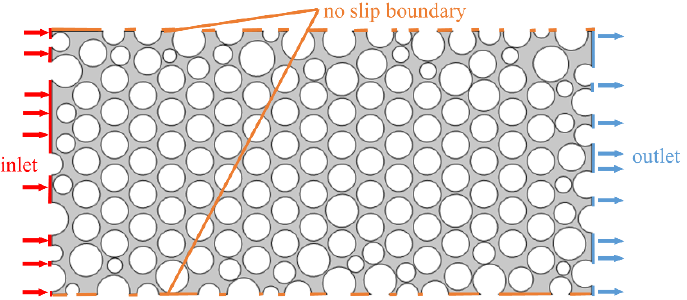
19 of 26 Figure 17. Saturation ( S C ) vs. PV for different interfacial tension. 3.3.6. Effect of Absolute Permeability on Fluid Flow